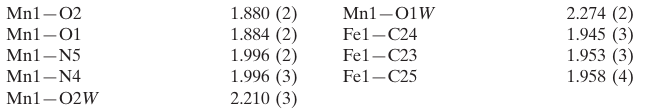
Rigaku Mercury CCD diffractometer Absorption correction: multi-scan ( CrystalClear ; Rigaku, 2002) T min = 0.871, T max = 0.910